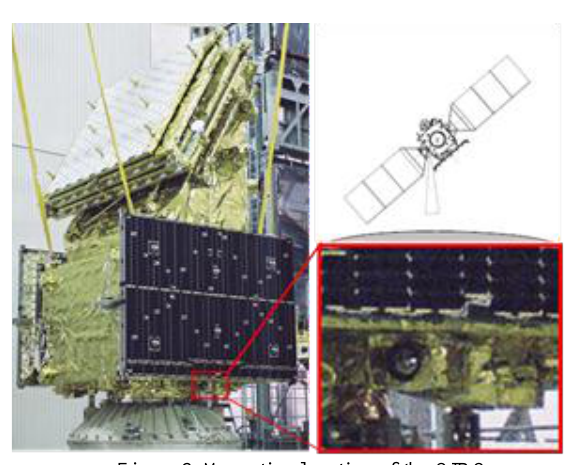
Table 1. Specifications of CIRC